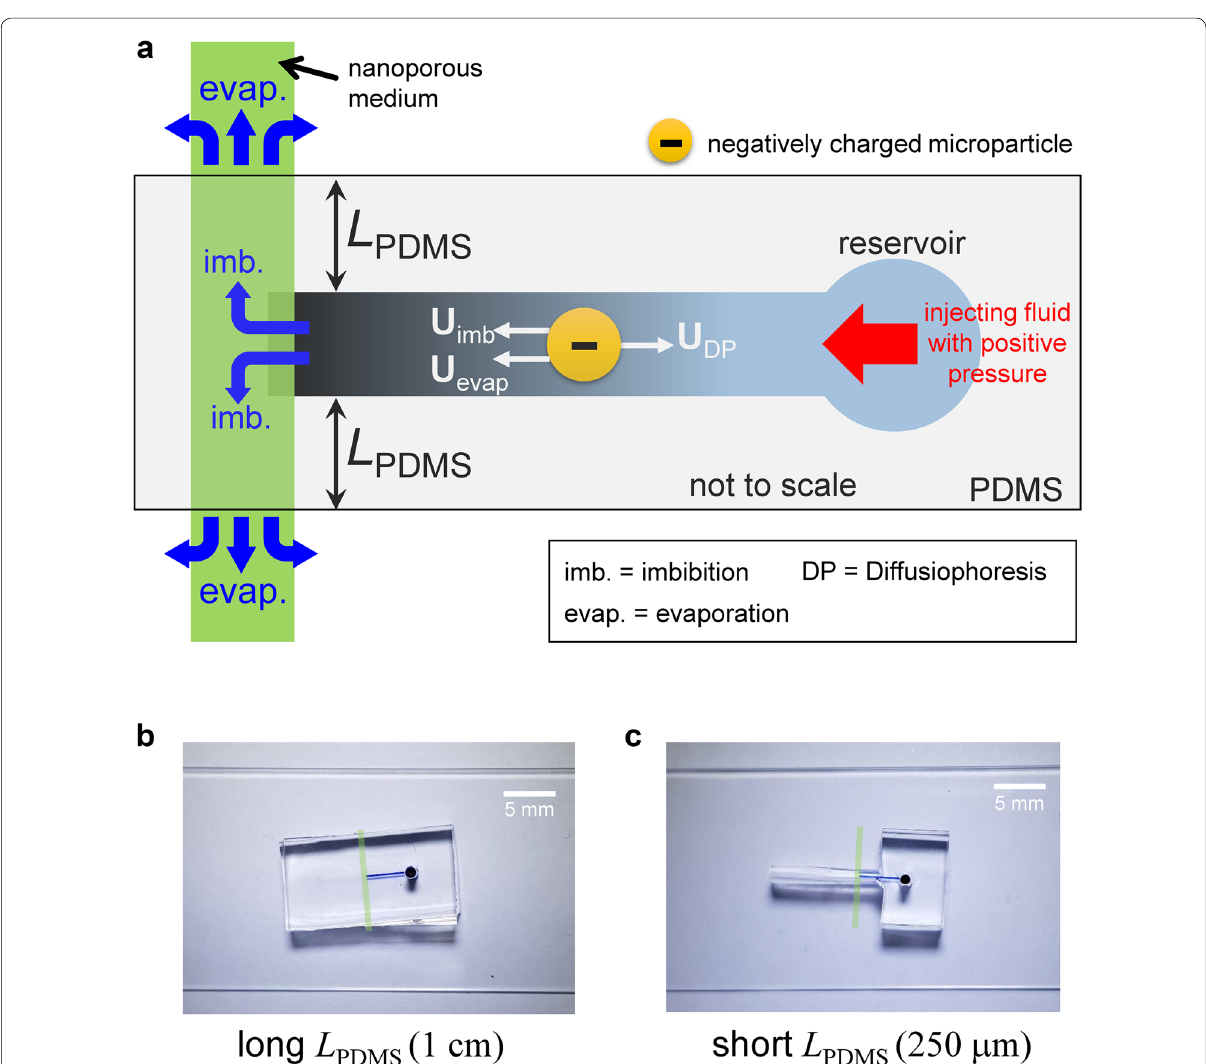
Fig. 1 a The schematic of spontaneous particle exclusion zone induced by diffusiophoreis near the nanoporous medium. U imb is the imbibition velocity, U DP is the diffusiophoretic velocity, U evap is the velocity induced by evaporation through the medium. L PDMS is the distance of PDMS between the channel and the medium exposed to air (the location of starting evaporation). Fabricated devices of L PDMS : b 1 cm and c 250